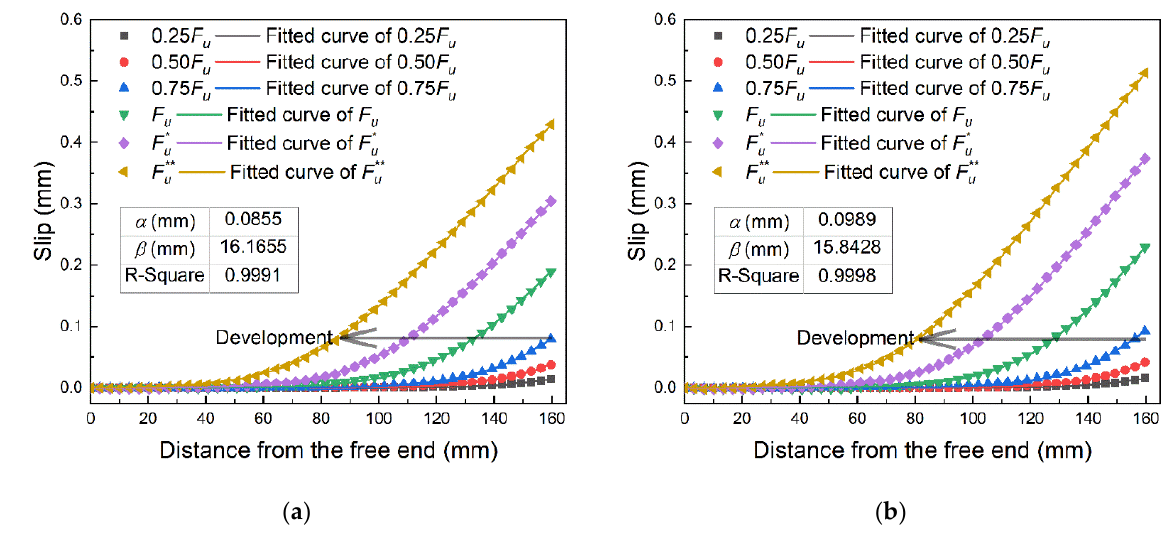
Figure 8. The slip distribution data and the fitted curves of: ( a ) Specimen A4 (10 mm/min); ( b ) Specimen B2 (1000 mm/min).